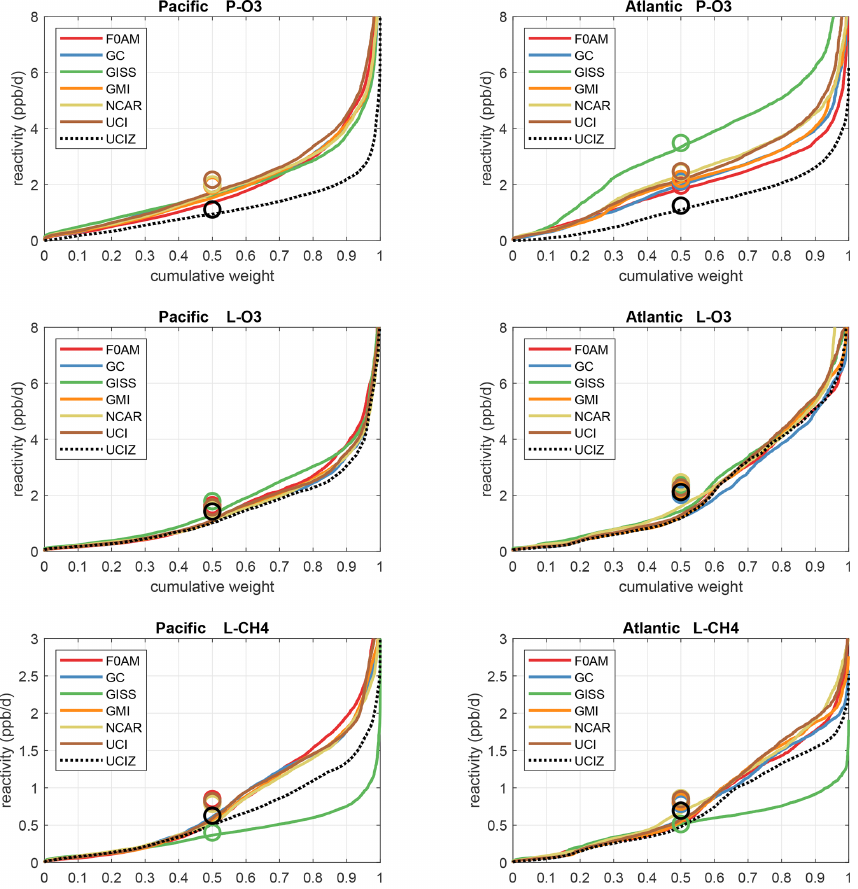
Figure 1. Sorted reactivities (P-O3, L-O3, and L-CH4, in ppbd − 1 ; three successive rows) for the Pacific and Atlantic domains (53 ◦ S– 60 ◦ N, two columns) of ATom-1. Each parcel is weighted, including cosine (latitude); see text. Results from six models using MDS-0 and the standard RDS protocol are shown with colored lines; the updated UCIZ CTM using MDS-2b with the RDS* protocol (HNO 4 and PAN damping) is shown as a dashed black line. The mean value for each model is shown with an open circle plotted at the 50th percentile. (Flipped about the axes, this is a cumulative probability density